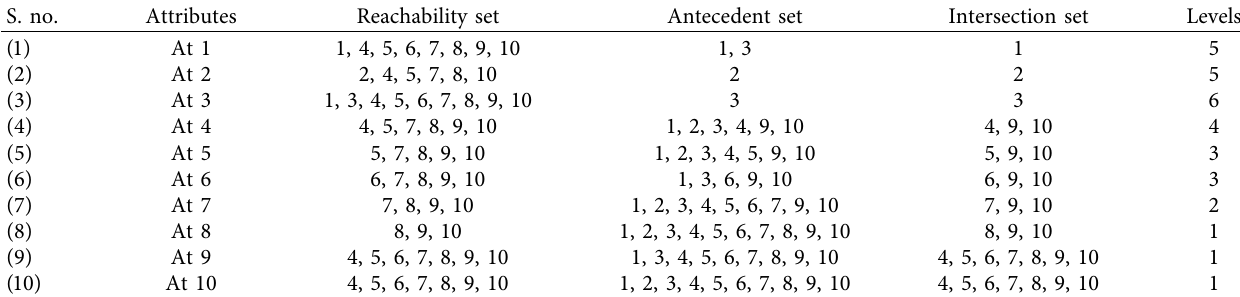
Table 5: Level partitioning of